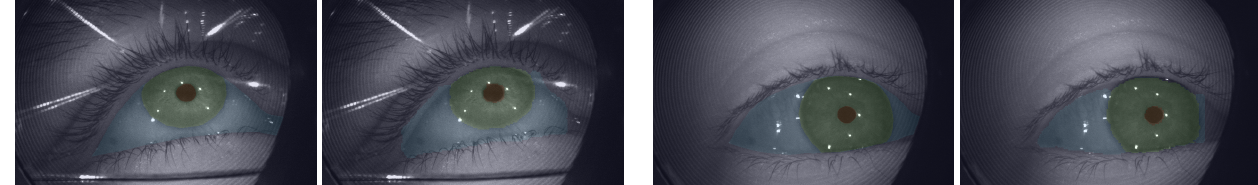
Figure 5. For each pair of images, examples of human annotations ( left ) and baseline model performance ( right ) for eye semantic segmentation (best viewed in